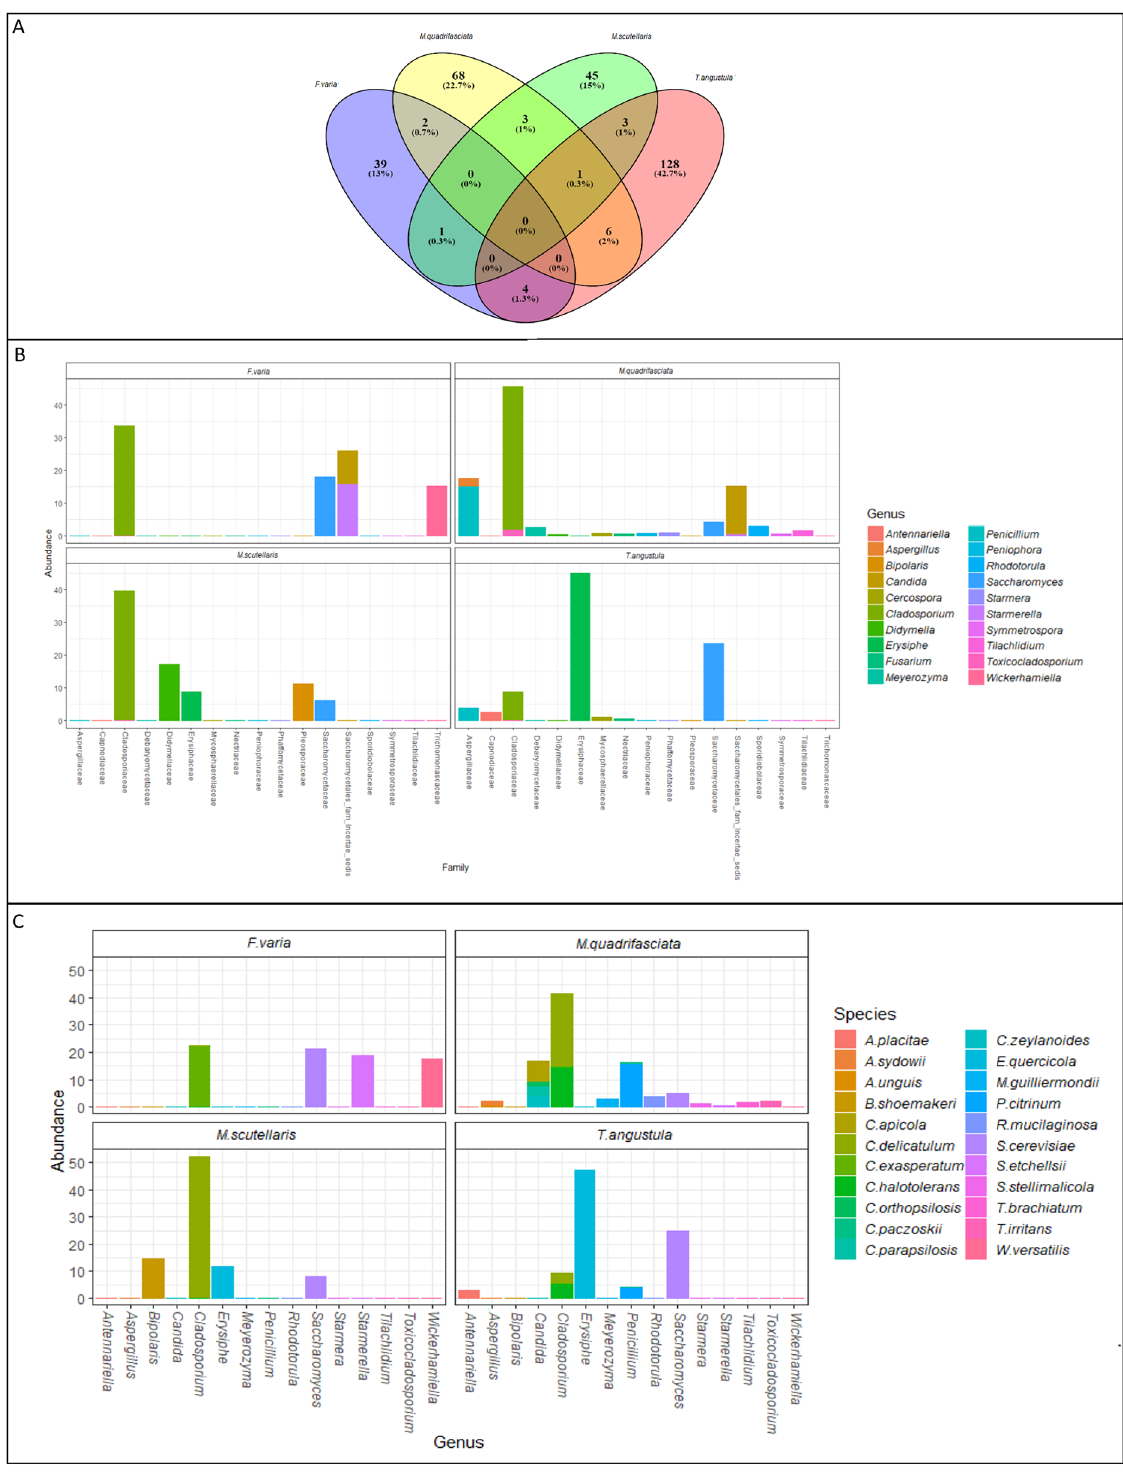
Figure 2. ( A ) Venn Diagram of ASVs classified for stingless bees; ( B ) Genus × Family histogram of 20 genera most abundant; ( C ) Species × Genera histogram of 22 species most